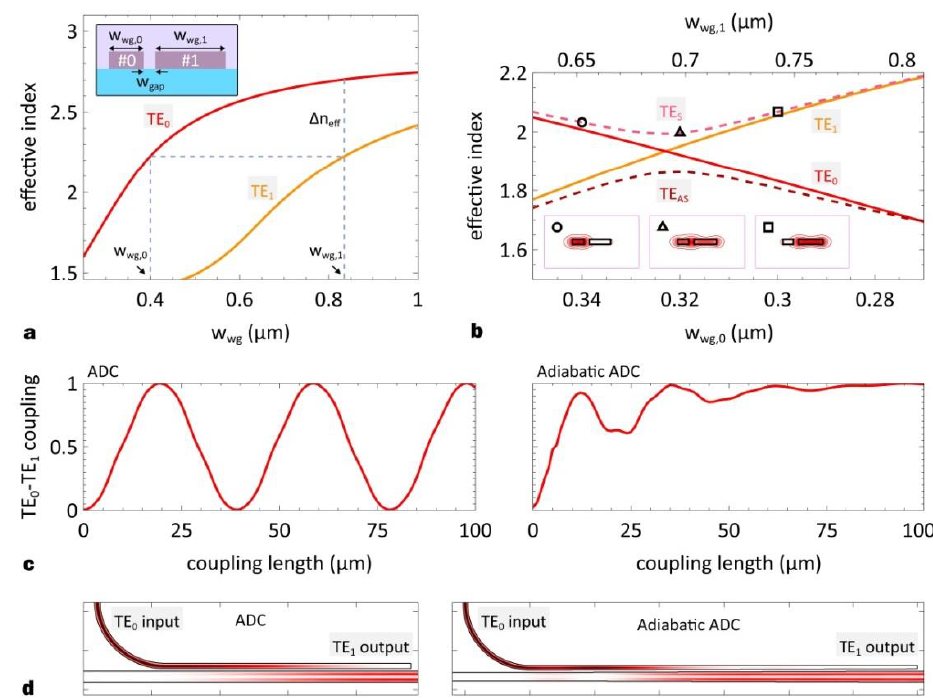
Figure 4. ( a ) The calculated e ff ective indices for TE 0 and TE 1 modes in a SOI waveguide with varied waveguide width (w wg ). The inset shows the cross-section of an ADC with some key parameters labeled. ( b ) The calculated e ff ective indices for TE 0 and TE 1 modes (solid lines) and TE S / TE AS super-modes (dashed lines) in an ADC with varied waveguide width (w wg,0 and w wg,1 ). The inset shows the mode profiles. ( c ) The calculated TE 0 –TE 1 coupling ratio for ADC (left panel) and adiabatic ADC (right panel) with varied coupling length. ( d ) The calculated light propagation profiles for ADC (left panel) and adiabatic ADC (right panel) when TE 0 mode is launched.